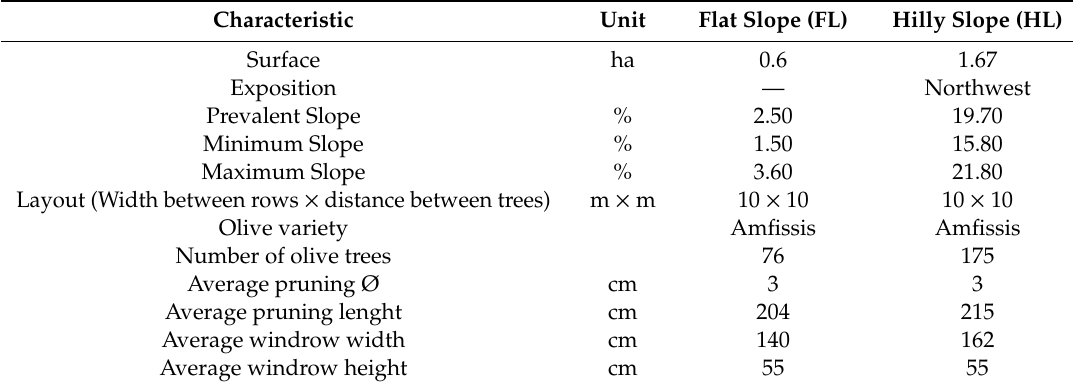
Table 1. Main characteristics of the olive groves.